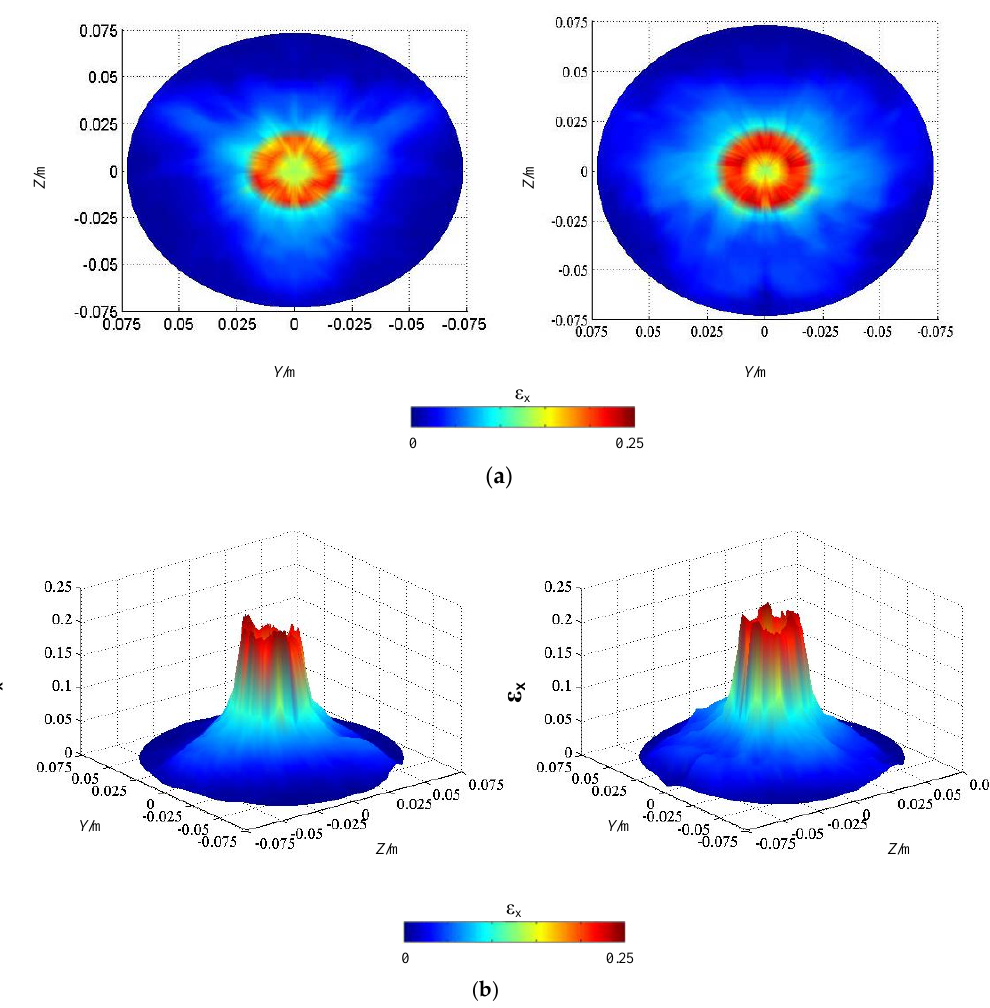
Figure 14. Comparison of turbulence intensity of wake field. ( a ) Two-dimensional turbulence in intensity of wake field at 0 ◦ C (left) and 25 ◦ C (right). ( b ) Three-dimensional turbulence intensity of wake field at 0 ◦ C (left) and 25 ◦ C